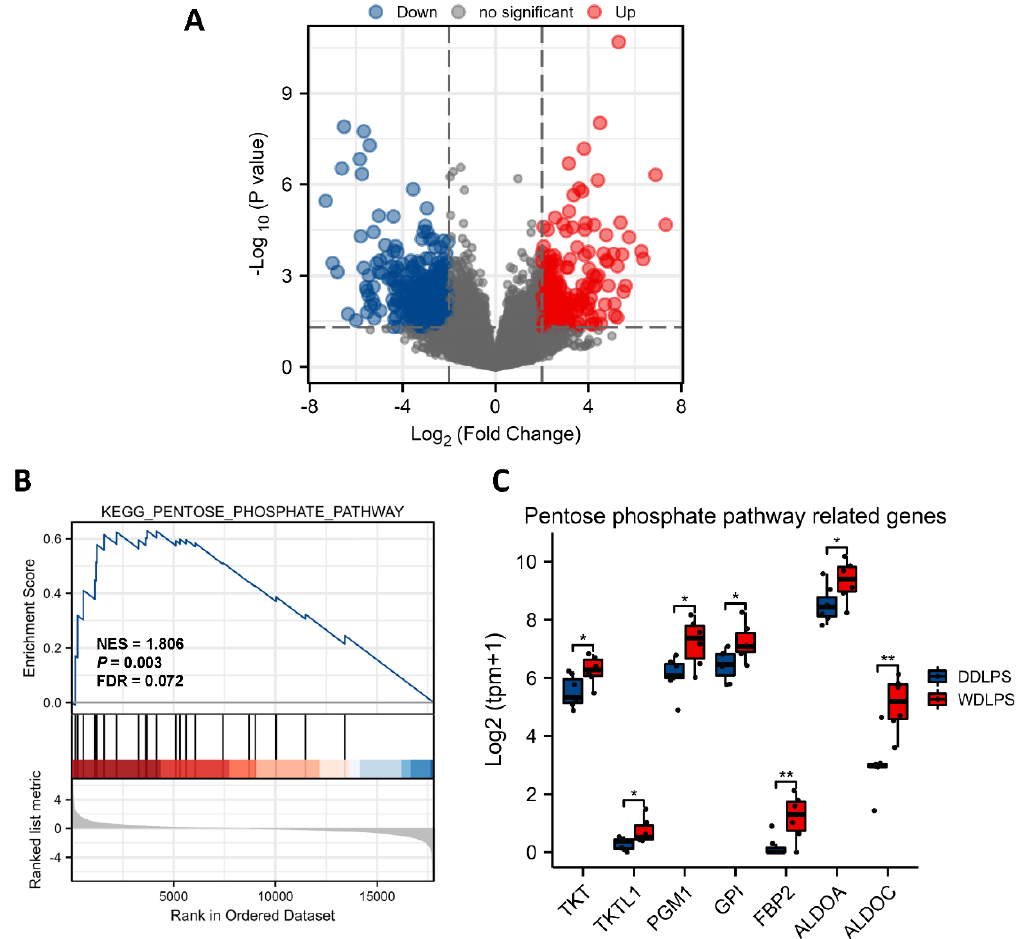
Figure 3. Transcriptomic features of WDLPS. (A) The volcano plot showing significantly changed genes in WDLPS compared to DDLPS. ( B ) GSEA indicated the significant upregulation of the pentose phosphate pathway in WDLPS. ( C ) Upregulated genes related to the pentose phosphate pathway in WDLPS. *, p < 0.05; **, p < 0.01.